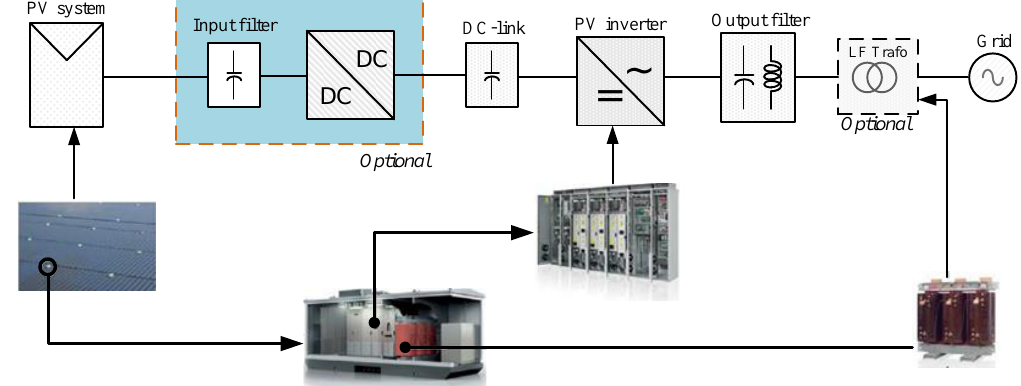
Figure 13. A generic structure of a PV-inverter-grid structure (Picture courtesy of ASEA Brown Boveri).